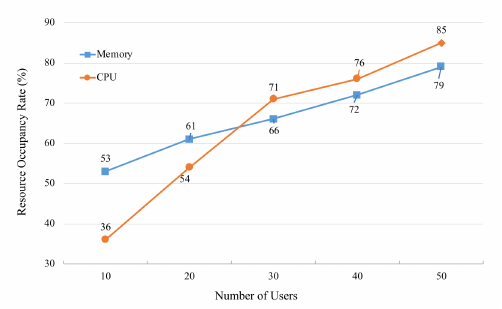
Figure 11. The accuracy of the original model and the improved